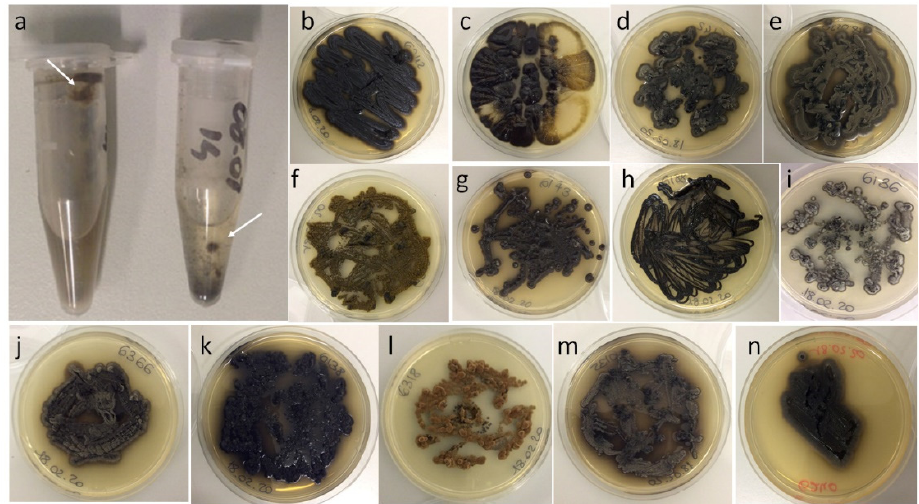
Figure 2. ( a ) Example of sample suspension vials after a long cold incubation (white arrows indicate fungal growth) and pure cultures of selected isolates: ( b ) E. phaeomuriformis CCFEE 6242; ( c ) Aureobasidium melanogenum CCFEE6236; ( d ) E. xenobiotica CCFEE 6142; ( e ) Exophiala sp. 2 CCFEE 6334; ( f ) Aulographina pinorum CCFEE 6222; ( g ) E. xenobiotica CCFEE 6143; ( h ) E. crusticola CCFEE 6188; ( i ) Neodevriesia sp. CCFEE 6136; ( j ) K. epidermidis CCFEE 6366; ( k ) K. epidermidis CCFEE 6138; ( l ) Scolecobasidium sp. 1 CCFEE 6318; ( m ) Exophiala sp. 1 CCFEE 6135; ( n ) E. heteromorpha CCFEE 6240.